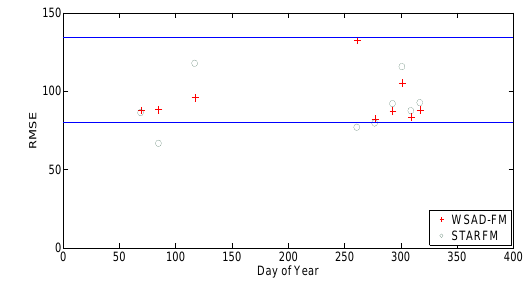
Figure 13. RMSE values for predicted NDVIs of Landsat images at time t p .